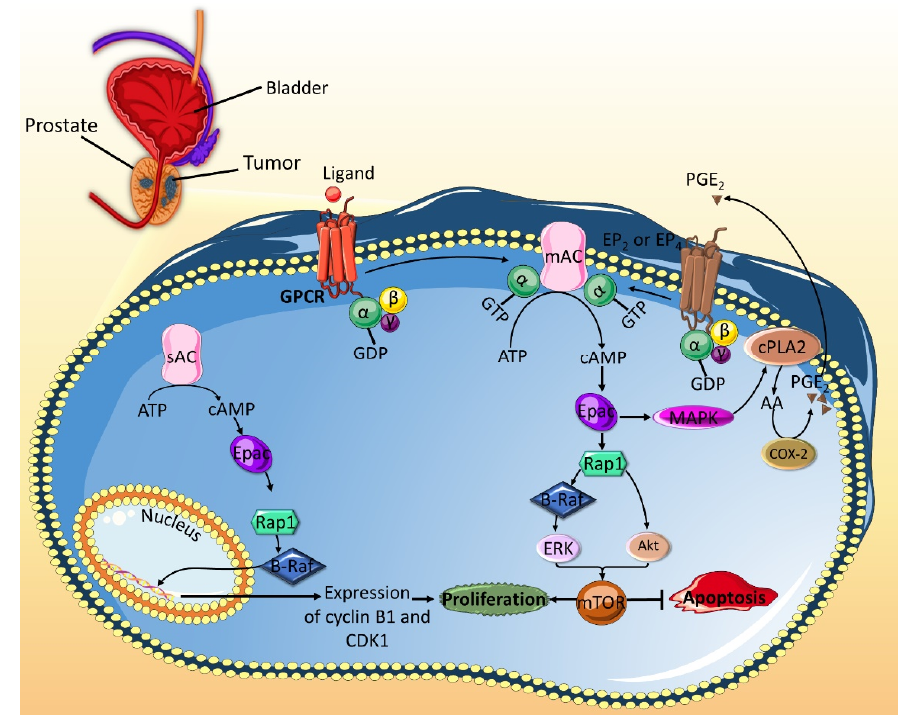
Figure 2. Epac promotes cell proliferation and attenuates apoptosis in prostate cancer. The activation of the soluble type 10 adenylyl cyclase (sAC) leads to the generation of cAMP, which in its turn activates Epac. Epac then induces the Rap1-dependent activation of B-Raf, which subsequently leads to increased expression of cell cycle proteins cyclin B1 and CDK1. These proteins mediate the G2/M phase transition of the cell cycle and promote proliferation. On the other hand, activation of the mAC leads to cAMP generation and subsequent activation of Epac. Epac can then activate the B-Raf/ERK and the Akt pathways, which both converge on mTOR. The activated mTOR mediates pro- proliferative and anti-apoptotic roles. These effects are amplified by the pro-inflammatory role that Epac can play. Indeed, Epac activates MAPK, which the activates cPLA2. The latter changes membrane phospholipids into AA, which is acted upon by COX-2 to produce PGE2. The PGE2 produced by prostate cancer cell can diffuse to the tumor microenvironment to activate EP2 and EP4 receptors on the cell itself or neighboring cells. EP2 and EP4 receptors are associated with G stimulatory proteins, which lead to further activation of mAC and subsequent accumulation of cAMP/Epac. AA: arachidonic acid; COX-2: cyclooxygenase-2; cPLA2: cytosolic phospholipase A2; cyclooxygenase-2; cPLA2: cytosolic phospholipase A2; EP2: PGE2 receptor 2; EP4: PGE2 receptor 4; mAC: membrane bound adenylyl cyclase; PGE2: prostaglandin